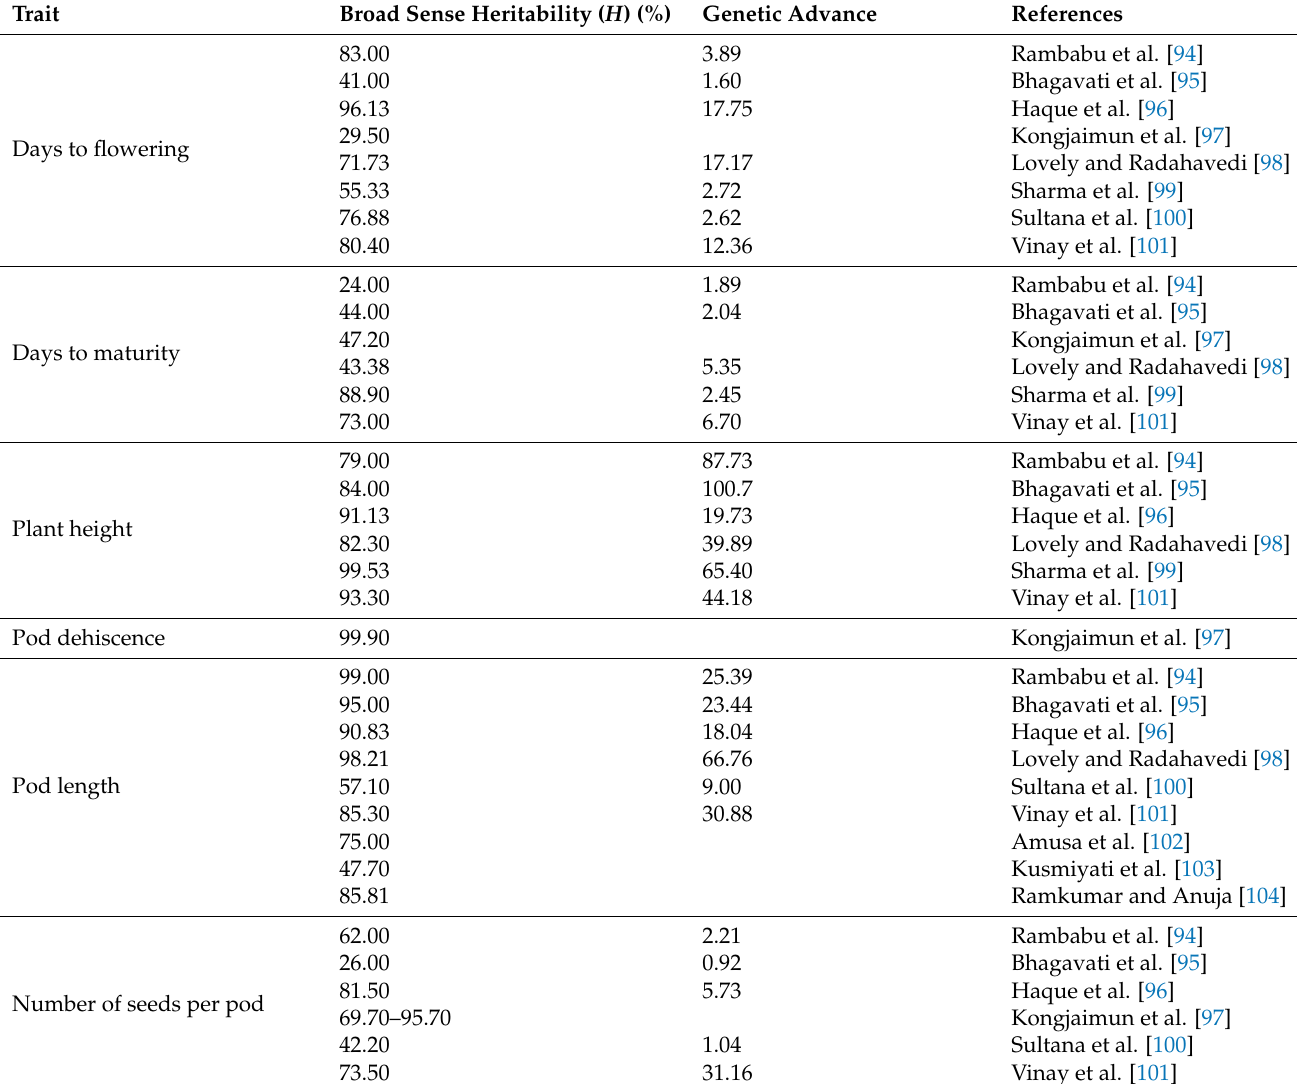
Table 2. Heritability in the broad sense and genetic advance of cowpea ( Vigna unguiculata cv-gr sesquipedalis)